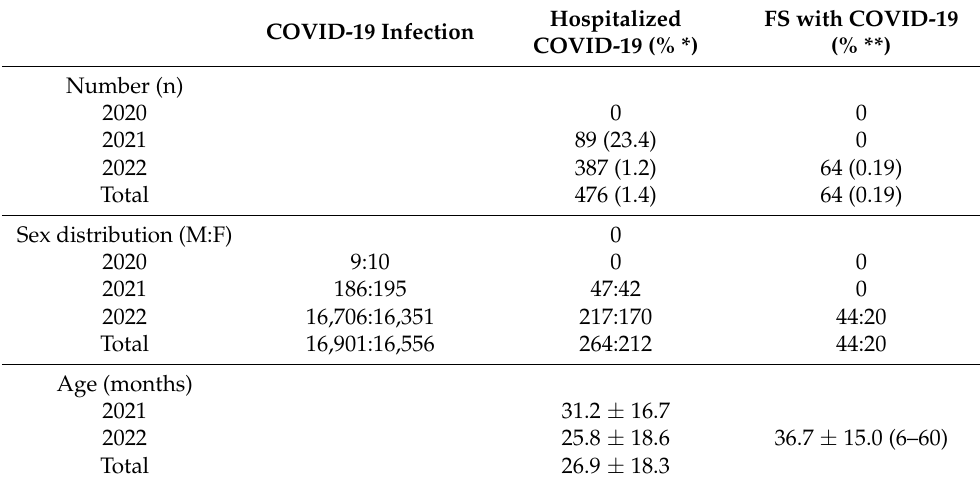
Table 1. Demographic features of children with coronavirus 2019 in Jeonbuk.